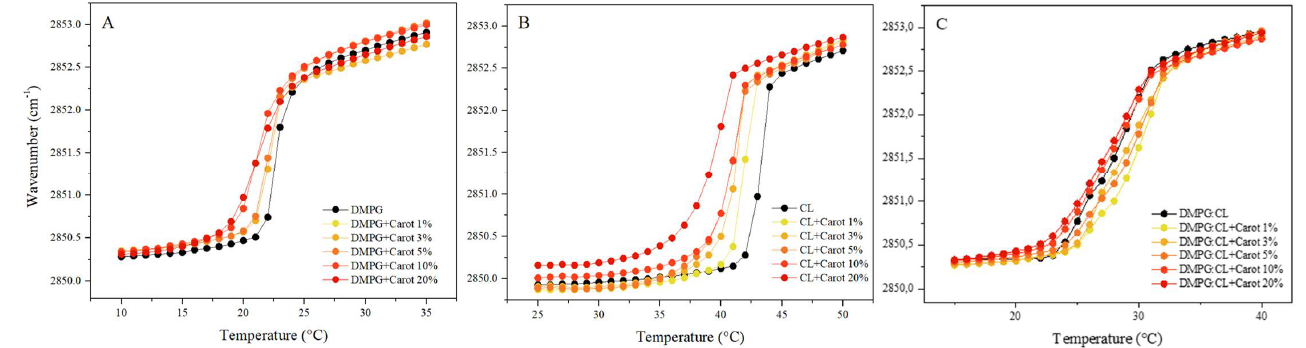
Figure 4. Peak positions of the ν s CH 2 vibration bands of the methylene groups as a function of temperature of total carotenoid extract incubated with ( A ) DMPG, ( B ) CL, and ( C ) DMPG:CL (80:20). The interaction of carotenoids with both lipids resulted in a shift of T m to lower values, as well as fluidization of the lipid systems. This effect is also evident at lower temper- atures (gel phase), where increasing concentrations of carotenoids are directly proportional to the wavenumber of the ν s CH 2 . The effect was more pronounced for the CL bi- layers, reducing the T m from 43.4 °C for the pure CL bilayers to 39.4 °C in the presence of 20% carotenoids. This effect might give evidence of a stronger alteration of lipid packing compared to DMPG, where T m was reduced from 22.9 to 21.7 °C at the same concentration of carotenoids (Table 2). These results are in agreement with the results obtained by DSC. Table 2. Phase-transition temperatures (T m ), of the fully hydrated supported bilayers of DMPG, CL, and DMPG:CL (80:20) by FT-IR. Standard deviations are ≤ 0.1 ◦ C. Lipids System/ Carotenoids (mol%)